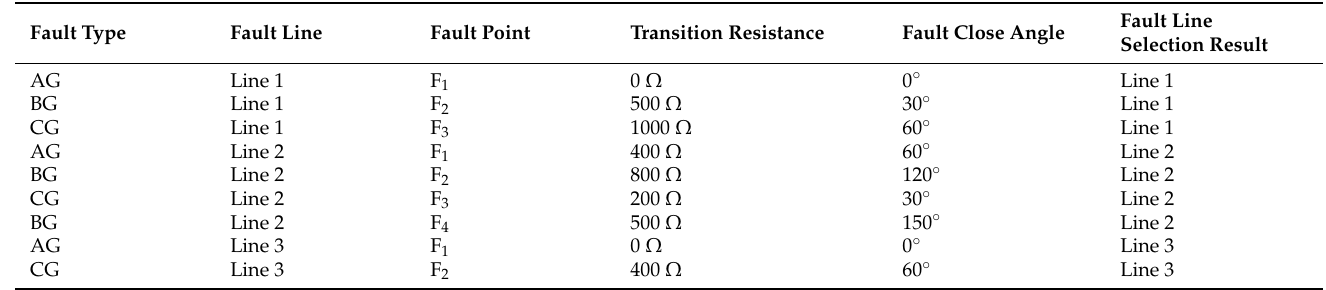
Table 8. Line selection results under the conditions of the dynamic simulation fault diagnosis experimental